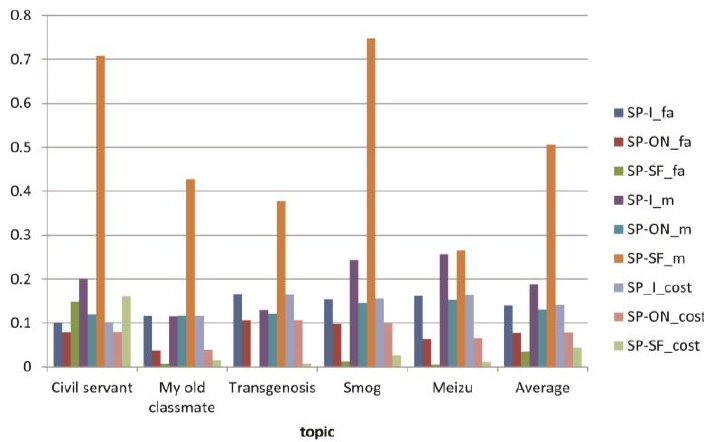
Figure 6. Topic tracking cost when similarity threshold is equal to 0.15.